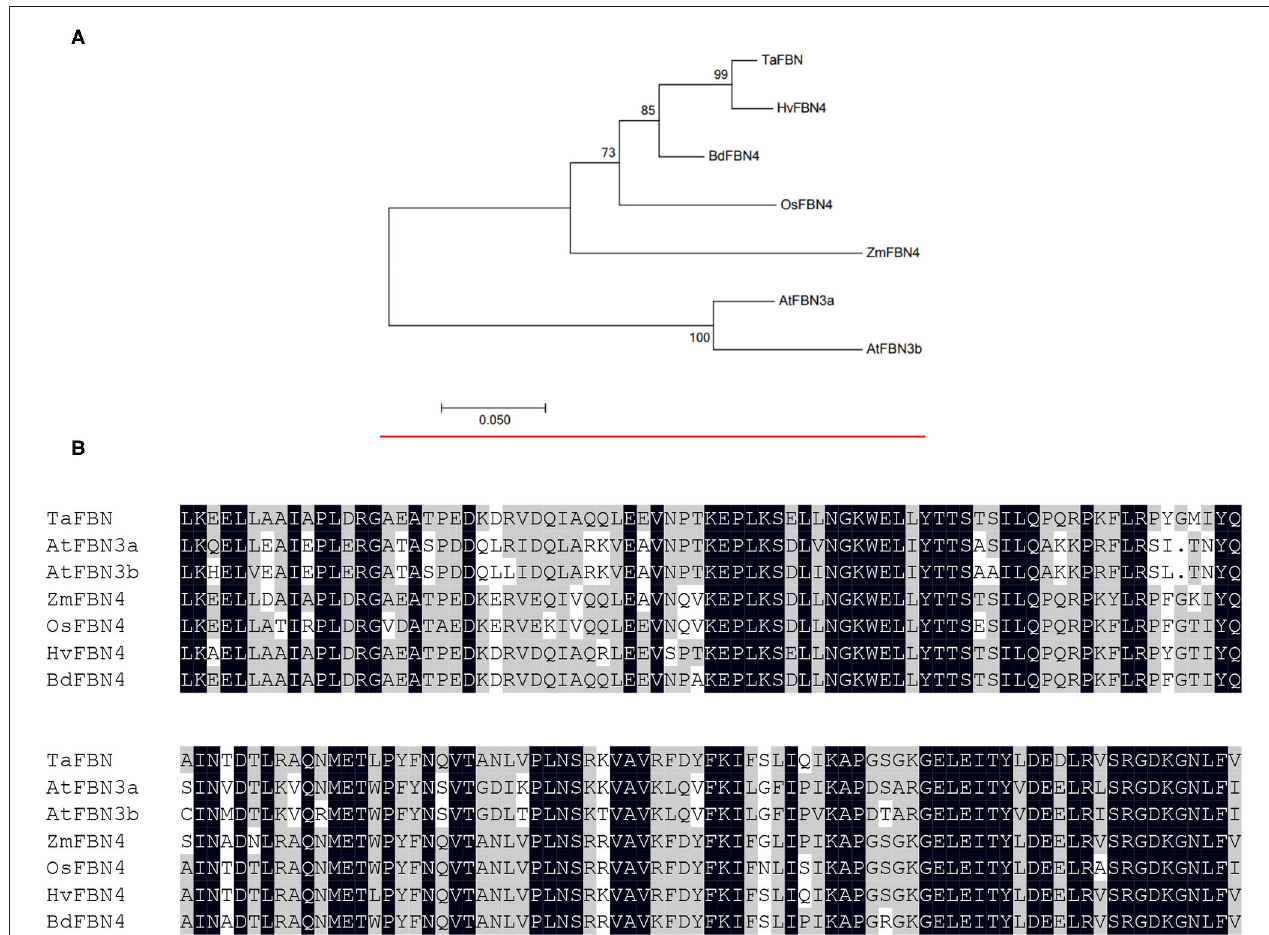
FIGURE 5 | (A) Phylogenetic analysis of fibrillin (FBN) proteins. A neighbor-joining tree of FBN in Triticuma estivum (TaFBN, KAF7095220), Hordeum vulgare (HvFBN4, KAE8820120) , Brachypodium distachyon (BdFBN4, XP_003560711), Oryza sativa (OsFBN4, XP_015632312), Arabidopsis thaliana (AtFBN3a/AT3G26070, NM_113511; AtFBN3b/At3g26080, BT020596), and Zea mays (ZmFBN4, ACG27798). (B) Multiple amino acid sequence alignments of TaFBN with OsFBN4, ZmFBN4, AtFBN3a, AtFBN3b, and HvFBN4. Amino acid identity (black boxes) and similarity (gray boxes) are shown within the protein kinase